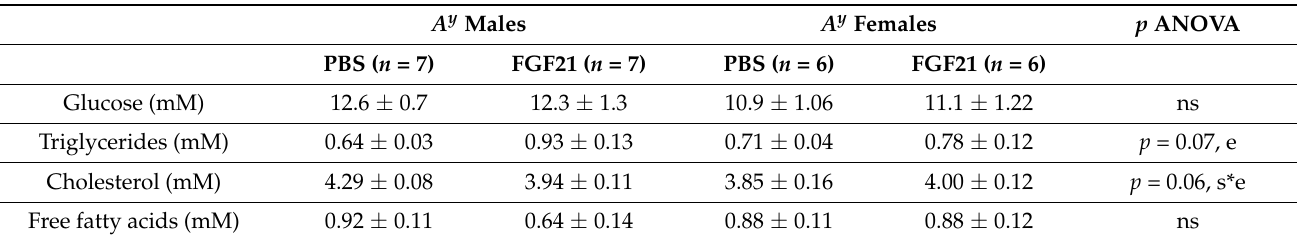
Table 3. Influence of FGF21 administration on blood parameters in obese A y male and female mice. Results are presented as * p < 0.05, FGF21 vs. PBS, males; # p < 0.05, females vs. males, post hoc Newman–Keuls test. Significant influence ( p < 0.05) mean ± SE for the indicated number of mice. Data were analyzed with two-way of factors “e” (administration of PBS or FGF21), “s” (sex), and “s*e”, or non-significant “ns”, two-way ANOVA, are indicated in the last column.